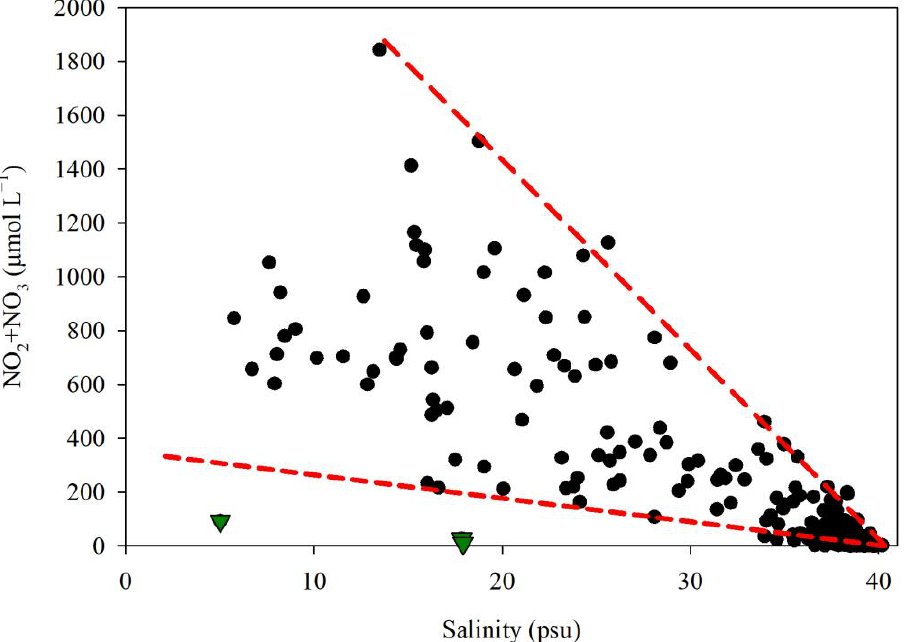
Figure 3. Relationship between NO 2 − + NO 3 − concentrations and salinity in surface water at three stations along the Kishon lower estuary between 2002 – 2021. The bottom green triangles represent measured values at a period of almost no anthropogenic discharge (November 2017) due to a strike at the fertilizer industrial plant. The red lines represent mixing curves between the highest and lowest NO 2 − + NO 3 − levels in the fresh/brackish water endmember and the seawater endmember (salinity ~40 psu).